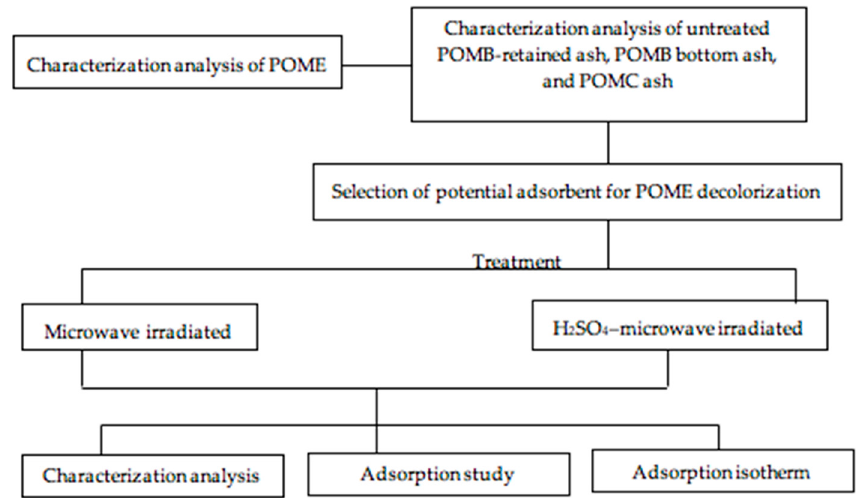
Figure 1. Flow chart of experimental work.